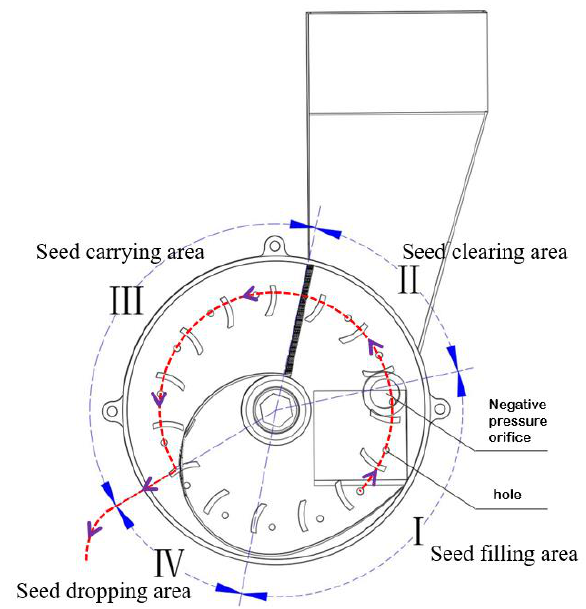
Figure 4. Schematic diagram of the disturbance air suction garlic seed metering device.